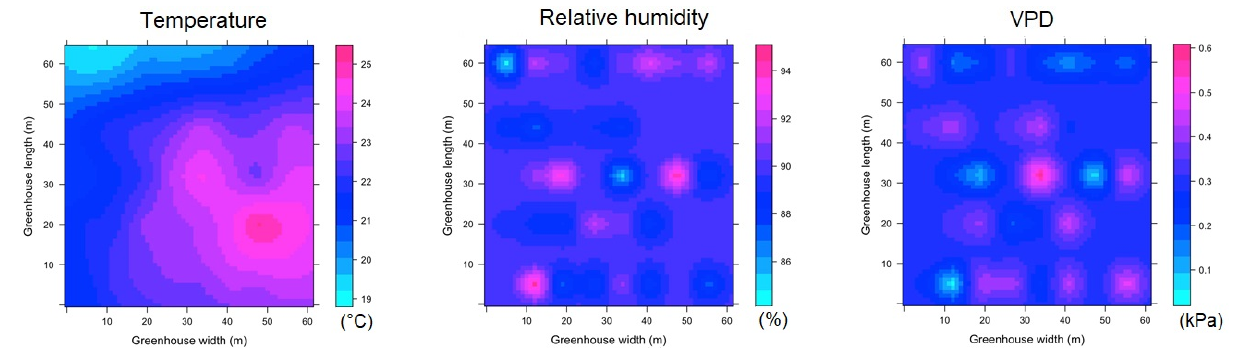
Figure 9. Spatial distribution predicted by kriging, for temperature, relative humidity and VPD in TG and for ESRL 1.